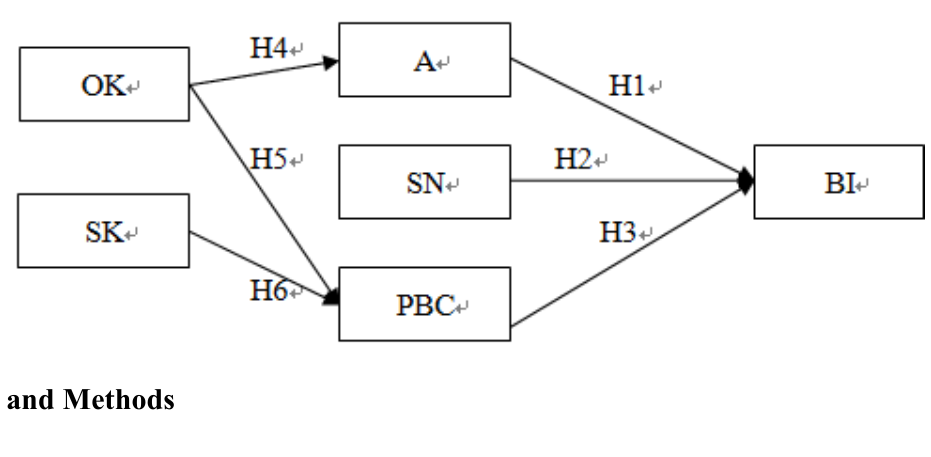
Figure 1. The hypotheses in this